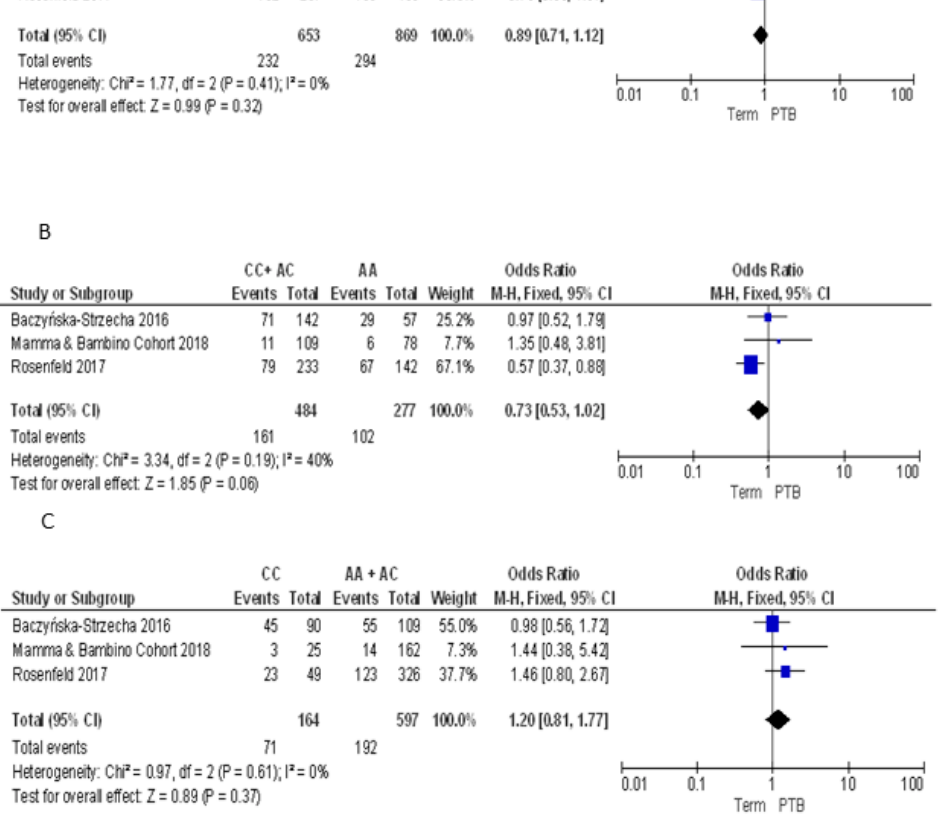
Figure 4. Forest plots of the association between BsmI polymorphism and preterm birth under the ( A ) allelic, ( B ) dominant and ( C ) recessive models.